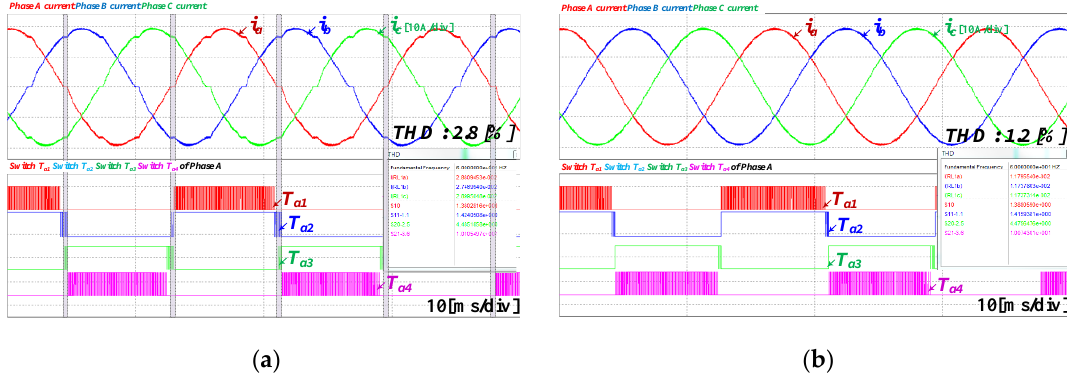
Figure 22. Simulation results of the proposed ZDPWM method applied in three-level NPC VSI: ( a ) Without delay compensation (10 ms/div); ( b ) With delay compensation (10 ms/div).